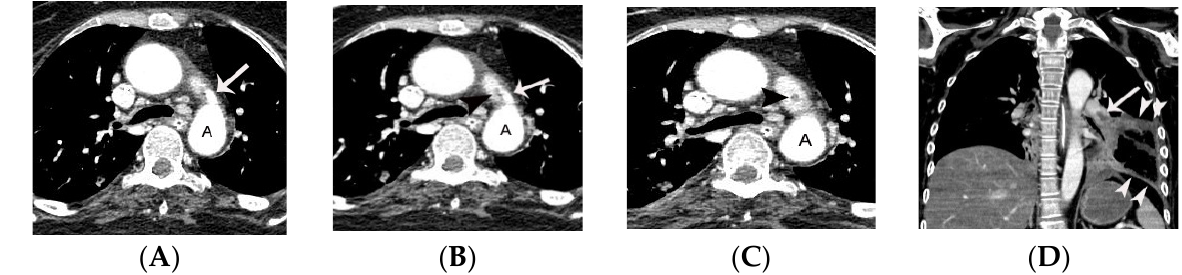
Figure 5. Septic pulmonary infarction caused by embolization of vegetation or endarteritis of a PDA in a 42-year-old female with history of glioblastoma multiforme. Small conically shaped PDA (arrow) is noted on contiguous axial CT images ( A – C ). Note small nodular lesion (arrowhead on C ) at the pulmonic end of the PDA, suggesting a vegetation or endarteritis. This finding was confirmed by subsequent echocardiography. Septic embolus is noted in the pulmonary artery in the left lower lobe (arrow on D ) on a coronal CT image at the level of descending thoracic aorta. Septic pulmonary infarction with necrosis (arrowheads on D ) is also demonstrated in the left lower lobe. This patient eventually died due to septic shock. A indicates aorta.